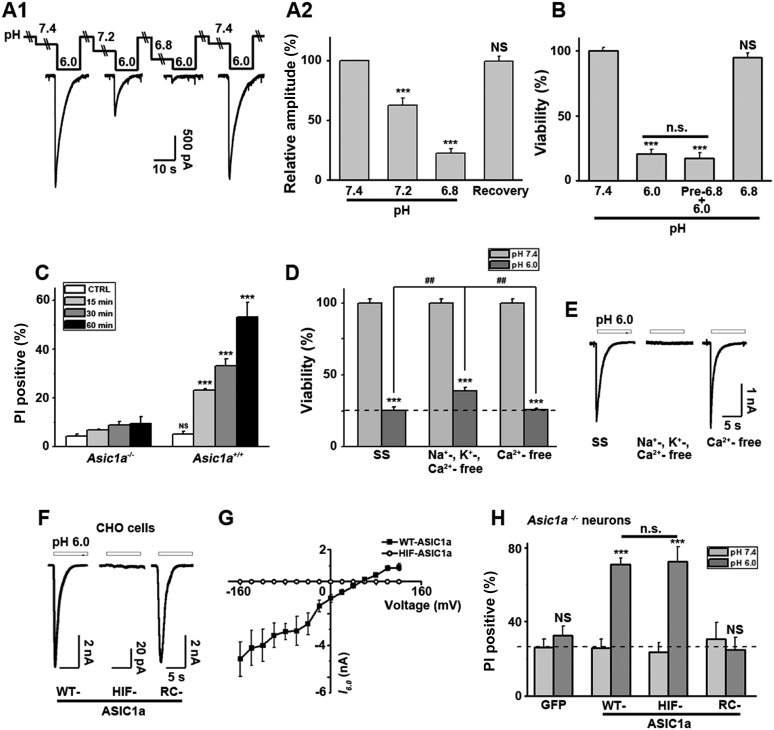
Ion-conducting function is not necessary for ASIC1a-mediated neuronal death.(A1, A2) Two-minute pretreatment with mild acidification greatly suppressed I6.0 in cultured mouse cortical neurons. Shown are representative current traces at −60 mV (A1) and summary data for peak currents (A2) (n=4–6, ***p<0.001; NS, no statistical significance, vs pH 7.4). (B) Pretreatment with pH 6.8 (Pre-6.8) for 10 min failed to prevent acid-induced neuronal death (CTB assay, n=4–6, ***p<0.001, NS, no statistical significance, vs pH 7.4; n.s., no statistical significance, vs pH 6.0). Note: treatment with the pH 6.8 solution for 1 hr only did not alter neuronal viability. (C) Summary of propidium iodide (PI)-positive neurons for Asic1a+/+ and Asic1a−/− cultures treated with pH 7.4 (CTRL) or pH 6.0 solutions for 15, 30, and 60 min. Representative images are shown in Figure 3—figure supplement 1B. At least 400 neurons were counted for each condition (***p<0.001; NS, no statistical significance, vs corresponding Asic1a−/− cultures). (D) Neuronal death induced by 1 hr treatment with the pH 6.0 solution in normal (SS, standard external solution), Na+-, K+-, Ca2+-free (NMDG replacement), and Ca2+-free conditions (CTB assay, n=3, ##p<0.01 vs Na+-, K+-, Ca2+-free in pH 6.0; ***p<0.001 vs pH 7.4 under the same cation conditions). Dashed line, pH 6.0 solution-induced neuronal death under normal SS condition. (E) Representative traces of I6.0 for cortical neurons in normal (SS), Na+-, K+-, Ca2+-free and Ca2+-free conditions. (F) Representative traces of I6.0 for wild type (WT) ASIC1a and its HIF and RC mutants expressed in CHO cells. (G) Current–voltage relationship of WT-ASIC1a (filled squares) and HIF-ASIC1a (open circles) in response to the pH 6.0 solution. Note: no current was induced by pH 6.0 in CHO cells that expressed HIF-ASIC1a at a broad range of holding voltages. (H) Summary data of cell death induced by 1 hr pH 6.0 solution treatment in Asic1a−/− neurons expressing GFP vector, WT-ASIC1a, and its HIF and RC mutants, based on PI staining of GFP-labeled neurons (see Figure 3—figure supplement 6 for representative images, n=100 for each condition, ***p<0.001; NS, no statistical significance, vs pH 7.4 of the corresponding transfection; n.s., no statistical significance, vs WT-ASIC1a).